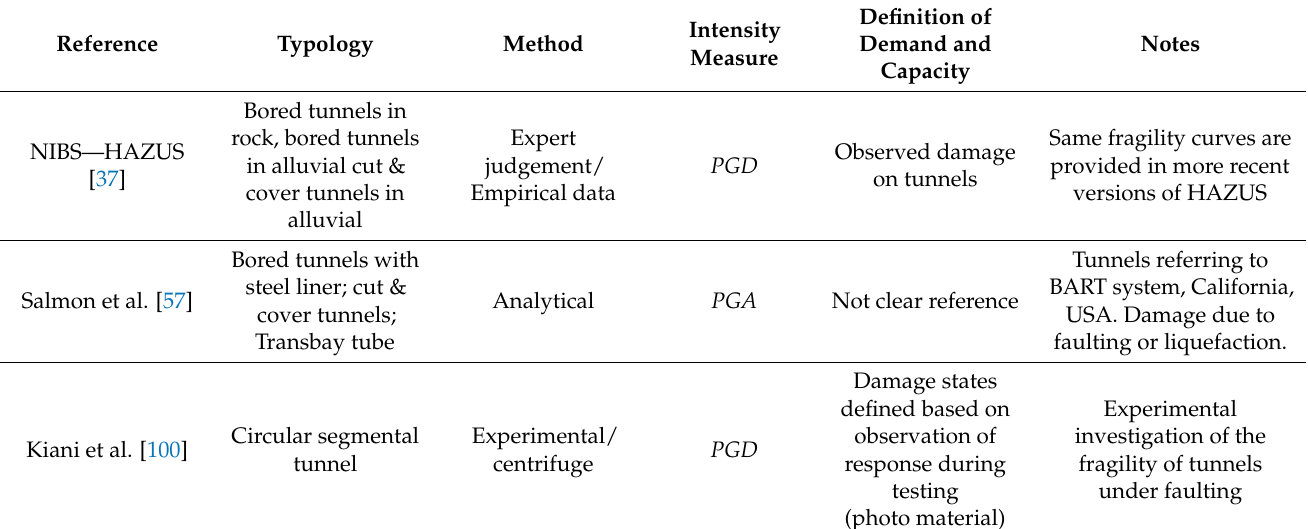
Table 6. Studies on fragility assessment of tunnels and underground structures subjected to seismi- cally induced ground